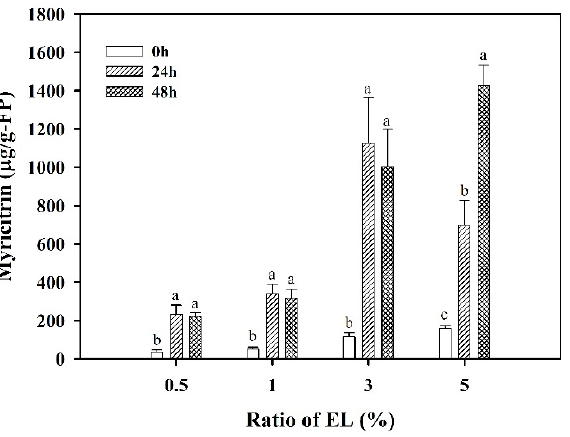
Figure 3. Comparison of various %EL on myricitrin content in fermented products at 0, 24, and 48 h of fermentation time. The data were expressed as mean ± standard deviations ( n = 3). Different letters at the same %EL were significantly different ( p < 0.05) by Duncan’s multiple range test.